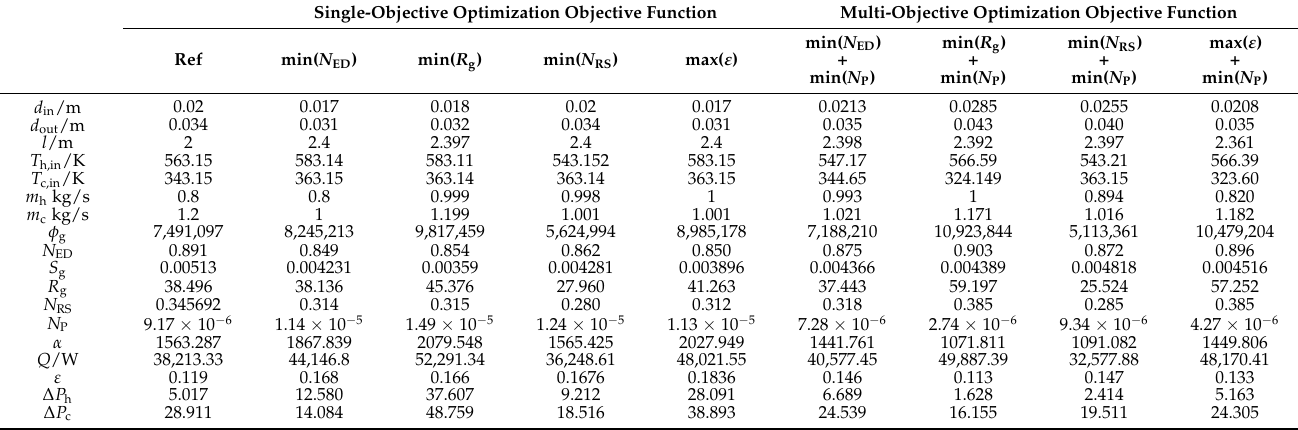
Table 5. Multi-objective optimization calculation